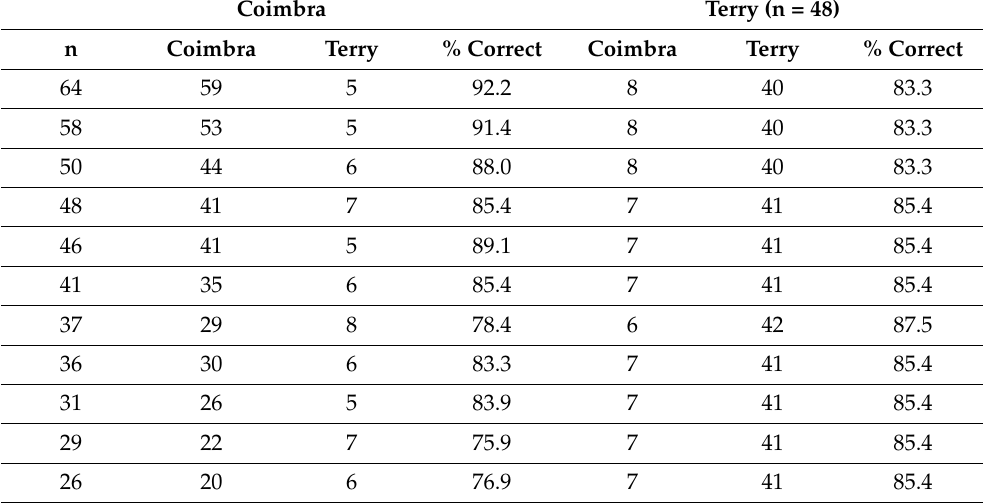
Table 3. Allocation accuracies using logistic regression with decreasing sample sizes from the Coimbra collection used to model mass grave scenarios with individuals whose sex was documented as female. Sample size from the Terry collection was held constant (n = 48) as a reference